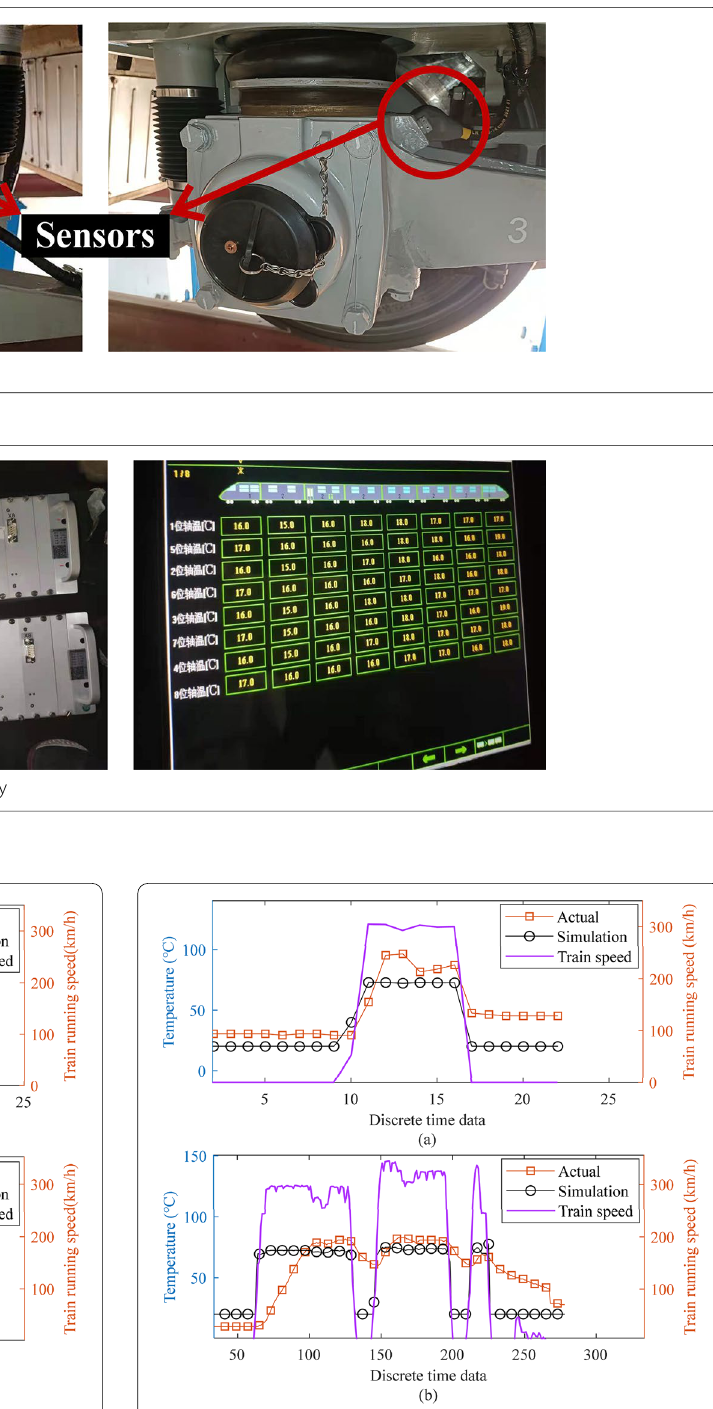
was higher than the simulation result. This is because the model only simulated the final state of the bearing temperature.